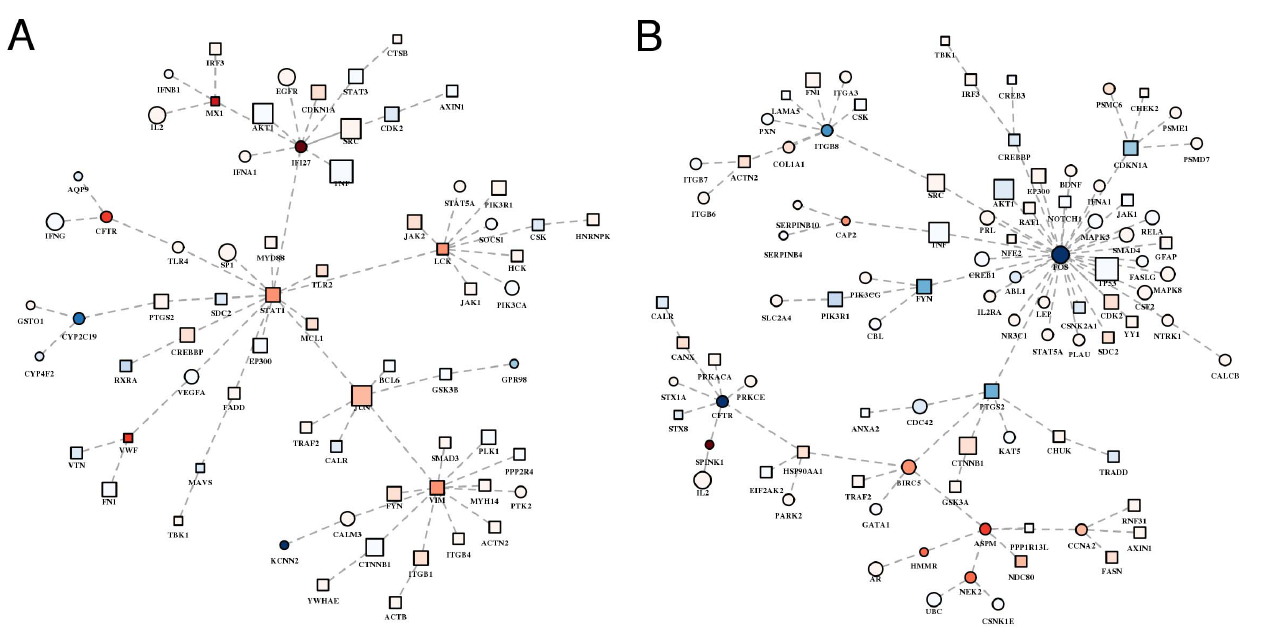
Figure 6. Most relevant relationships between proteins in network proximity to HCV and differentially expressed in preneoplastic and neoplastic liver samples. A ) CIR-NORM. B ) HCC-CIR. A–B ) Colors, from blue (lower values) to red (higher values): average fold change; squares: HCV targets; circles: non-HCV